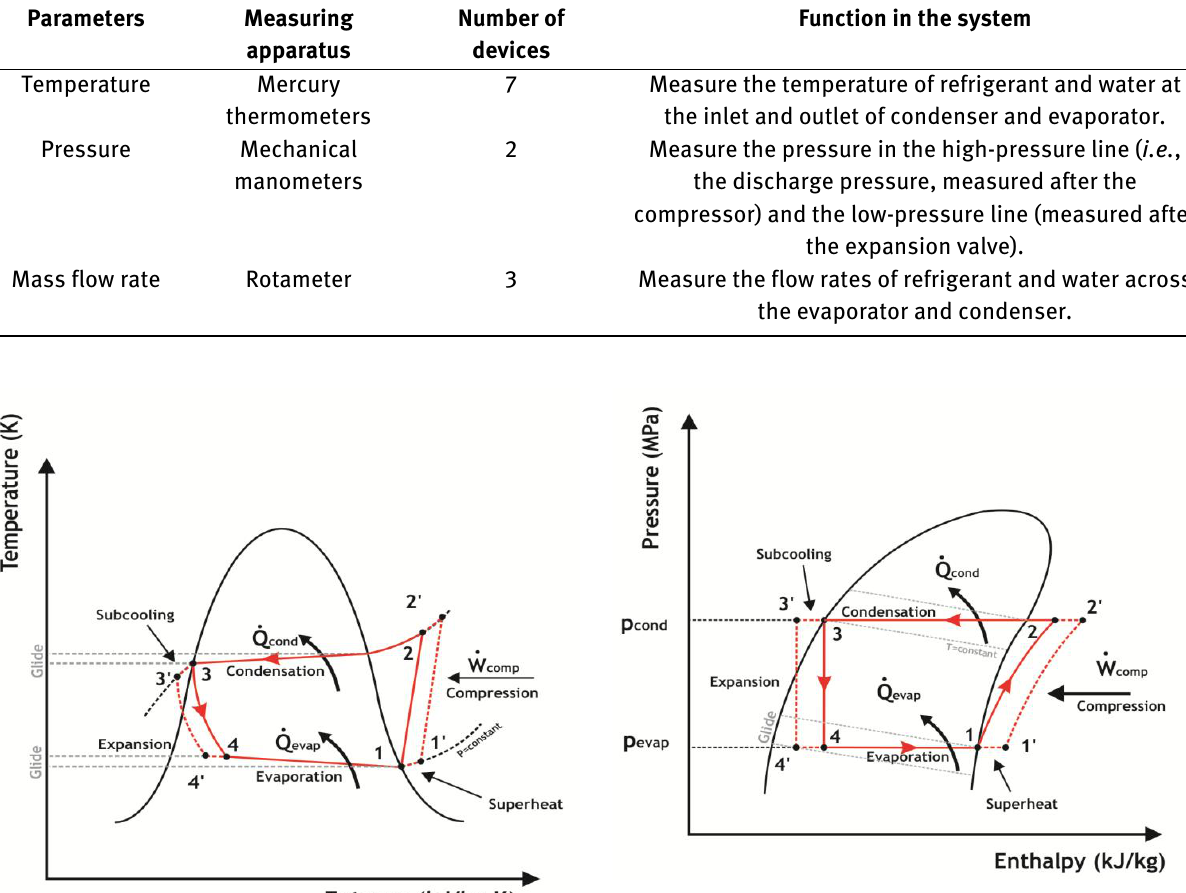
Table 2: Summary table with the instrumentation equipments used in the experimental set-up.